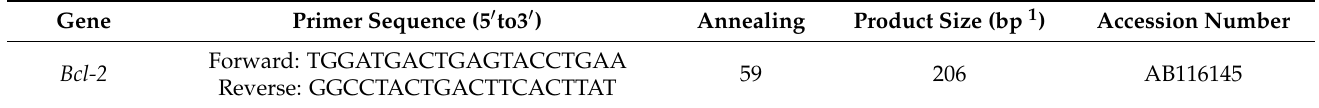
Table 1. Primer sequences for real-time